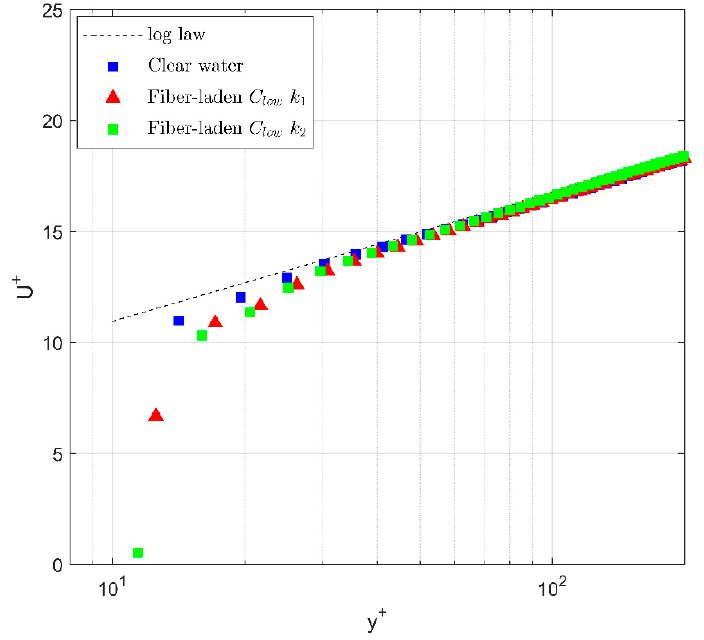
Figure 5. Carrier flow average stream-wise profile in wall coordinates. Clear-water case compared to the fiber-laden case at low concentration C low , two aspect ratios k 1 and k 2 .